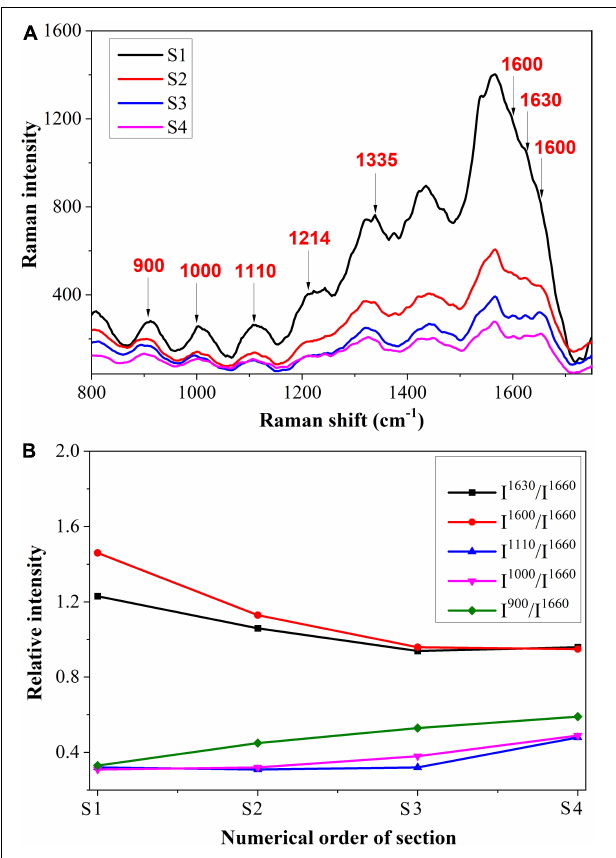
FIGURE 6 | (A) Raman spectroscopy and (B) Semi-quantitative intensity analysis of vascular bundle.